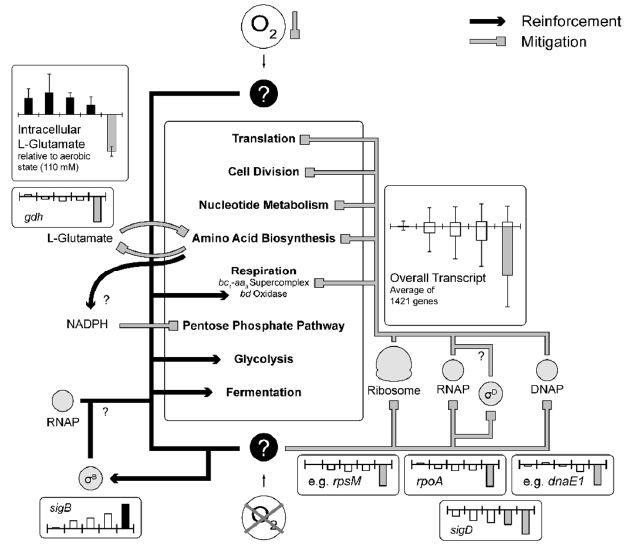
Figure 7. Hypothetical model of C. glutamicum ’s response to micro- and anaerobiosis including unknown regulatory mechanisms, metabolites, or cellular signals (?). Reinforcement and mitigation is visualized by arrowheads and squares, respectively. Column graphs (with exception of intracellular L -glutamate titers) represent log 2 -fold changes of enhanced (black) and reduced (grey) expression. Open columns are values outside the significance constraints ( m -value > 1.50, < − 1.50 and a -value > 1.00). From left to right aerobiosis ( ② ), microaerobiosis ( ③ , ④ , ⑤ ) and anaerobiosis ( ⑥ ) versus the aerobic reference ( 1 (cid:13) ; Figure 1A). Scaling of these graphs is variable. Intracellular L -glutamate pools are depicted relatively to aerobic intracellular titers analogously to differential expression column graphs. Error bars represent SD. Abbreviations: RNAP, RNA polymerase; DNAP, DNA